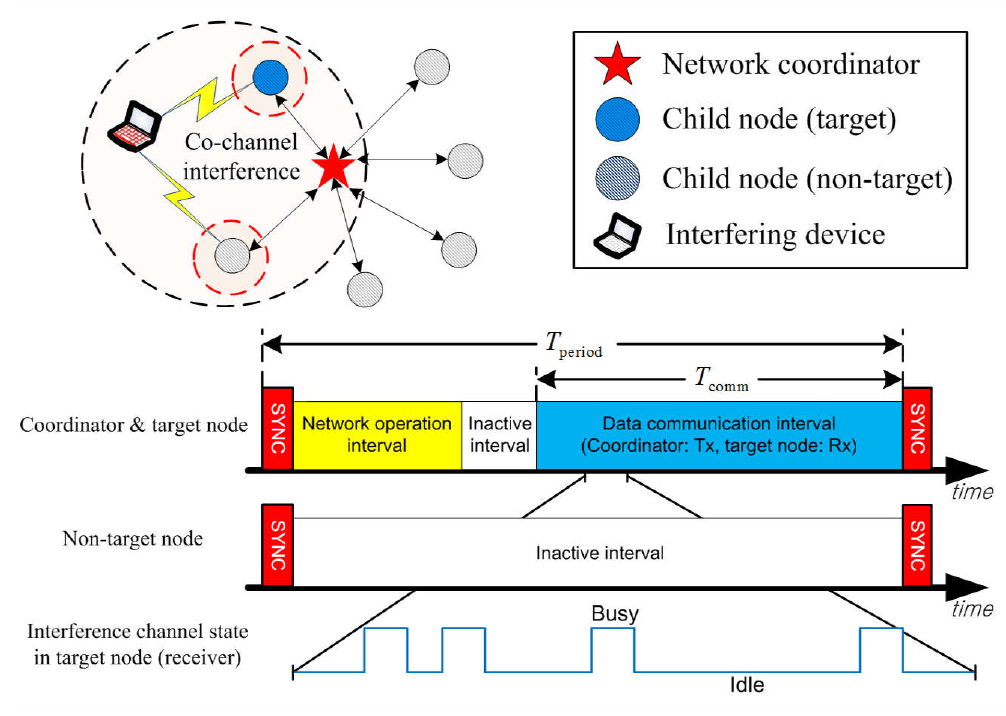
Figure 2. A star-topology WSN in a synchronized operation